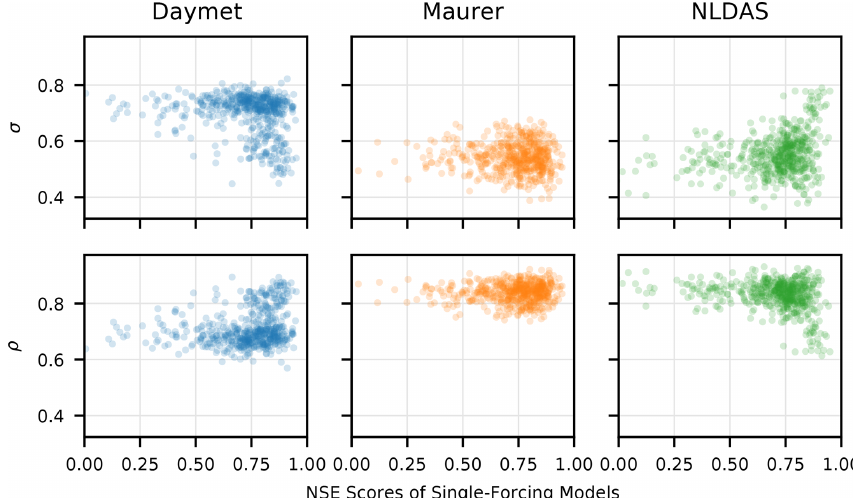
Figure C1. Triple collocation error variances ( σ – Eq. C4) and truth correlations ( ρ – Eq. C5) plotted against NSE scores of the single- forcing LSTM models. ρ describes how much correlation there is between the given data product and the estimated truth, and σ describes the estimated disagreement between a given data product and the other two data products. Daymet typically produces lower NSE values in basins where triple collocation reports that the precipitation error variances are high, whereas NLDAS produces lower NSE values in basins where triple collocation reports that the error variances are low. There is no apparent pattern in the Maurer data.